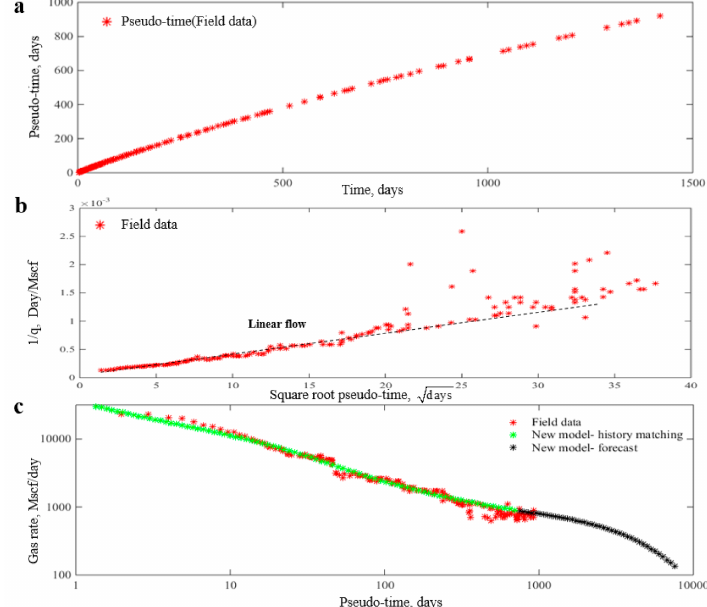
Figure 8. Summary of production profiles for the field example. ( a ) The relationship between time and pseudo-time. ( b ) The plot 1 / q vs. square root pseudo-time for regime diagnosis. ( c ) The results of history-matching and forecasting on log-log